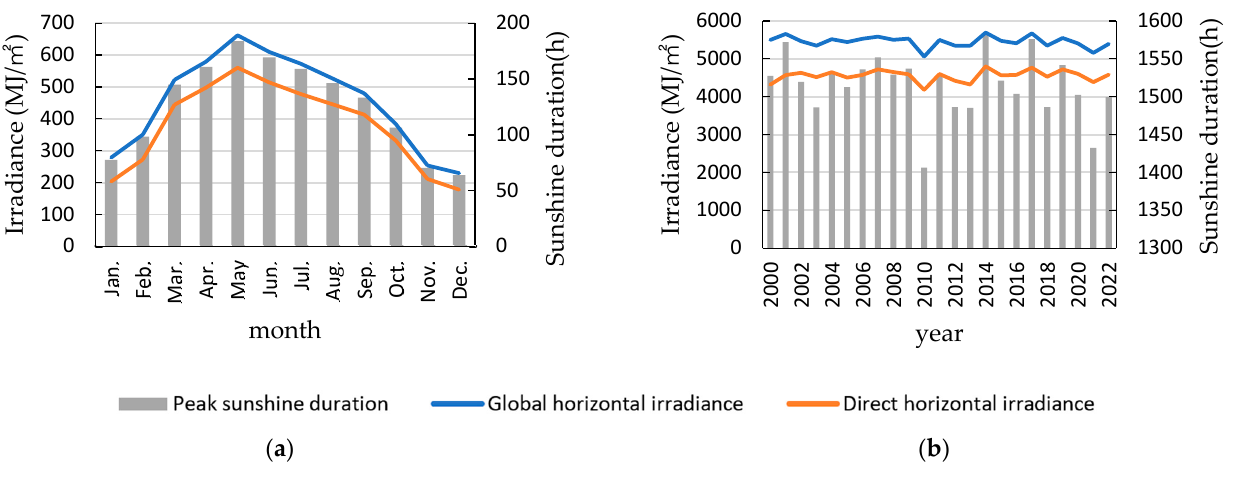
Figure 3. Statistics of solar radiation intensity and peak sunshine duration in Shenyang from 2000 to 2022: ( a ) mean monthly meteorological data statistics; ( b ) mean annual meteorological data sta- tistics.